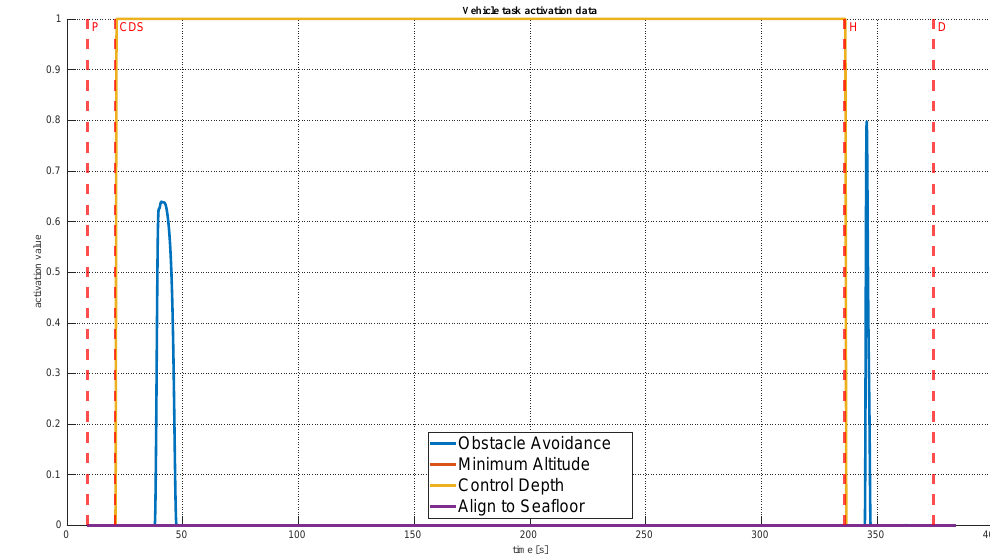
Figure 14. Constant depth mission: Time behavior of Obstacle Avoidance, Minimum Altitude, Vehicle Depth, and Seafloor Alignment task activation functions. The various phases of the mission are denoted in the plot as follows: P—Parking, CDS—Constant Depth Survey, H—Homing, D—Docking.